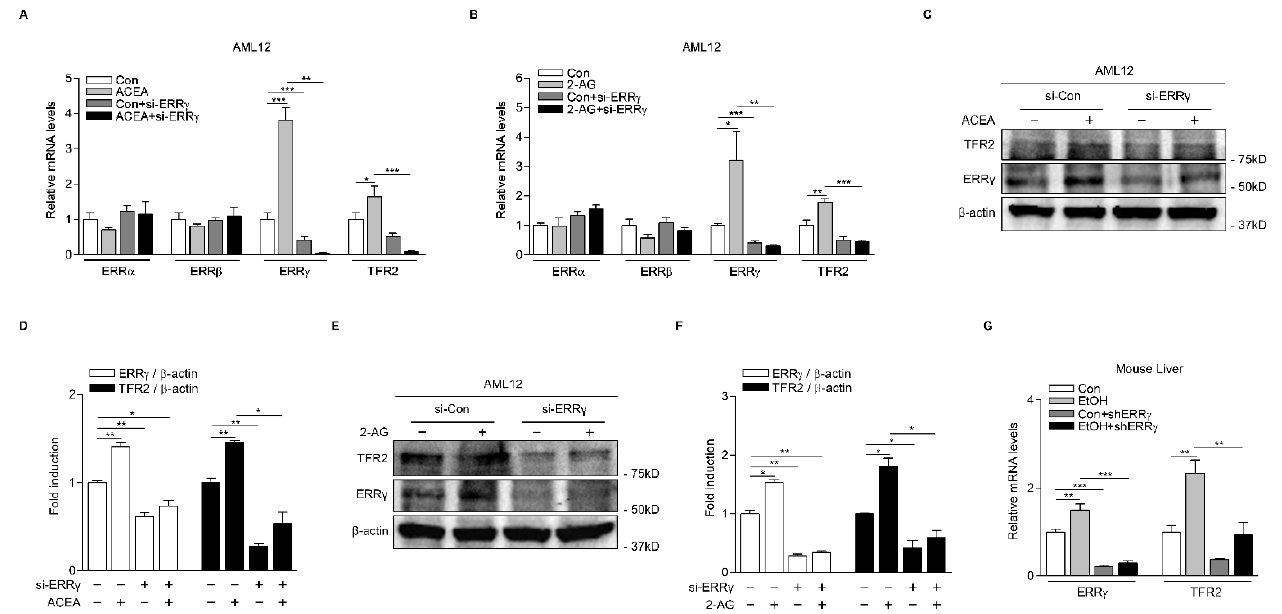
Figure 4. Knockdown of ERR γ decreases CB1 receptor-mediated TFR2 gene expression. ( A , B ) Q-PCR analysis showing ERR γ knockdown effect on CB1 receptor-mediated TFR2 mRNA levels. AML12 cells were transfected with si-Con or si-ERR γ for 48 h and then treated with either ACEA (10 μ M) ( A ) or 2-AG (10 μ M) ( B ) for 12 h. ( C – F ) Western blot analysis and graphical representation showing ERR γ and TFR2 protein levels. AML12 cells were transfected with si-Con or si-ERR γ for 48 h and then treated with ACEA (10 μ M) ( C , D ) and 2-AG (10 μ M) ( E , F ) for 12 h. ( G ) Ad-US or Ad-shERR γ were injected via tail veins of male C57BL/6J mice ( n = 5 per group). At day 6 after the injection, mice were treated with vehicle or alcohol (6 g/kg) for 24 h. Q-PCR analysis showing mRNA levels of ERR γ and TFR2 in livers of mice. All experiments were performed in duplicate ( C – F ) or triplicate ( A , B , G ) and repeated at least twice. Error bars show ± SD. * p < 0.05, ** p < 0.01, *** p < 0.001 by two-tailed Student’s t -test.